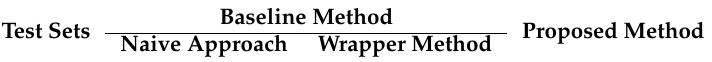
Table 4. Computational performance (in sec) between our method and the baseline methods. The results are the average of 30 runs on each test